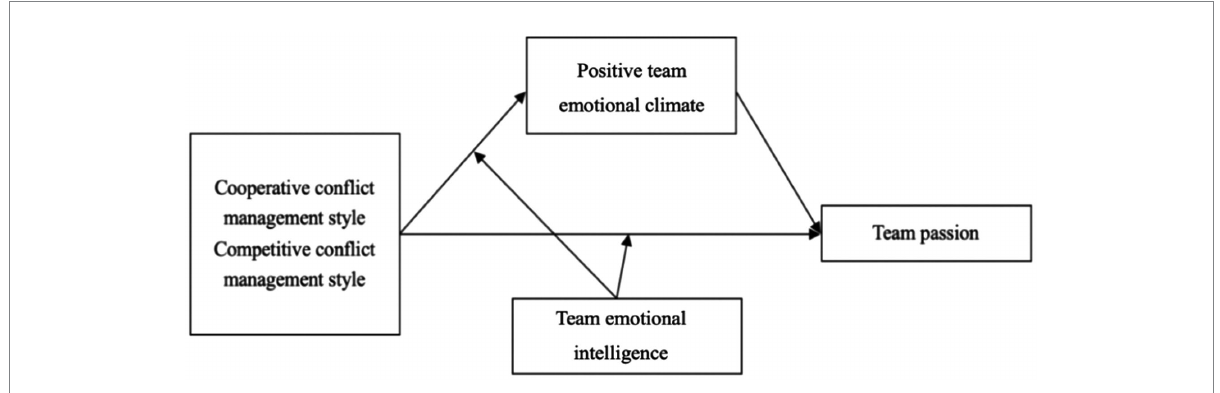
FIGURE 1 Conflict management styles on positive team emotional climate and team